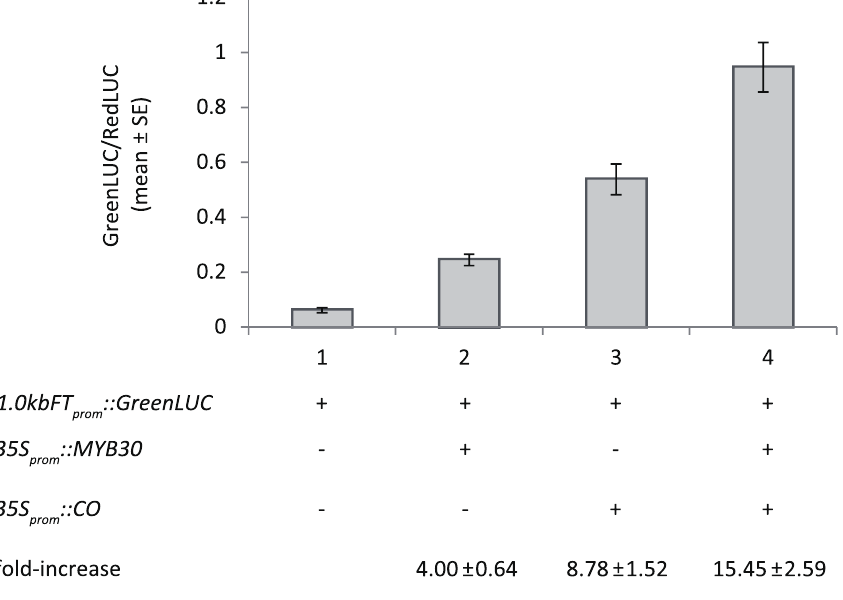
Figure 6. MYB30 increases 1.0 kb FT promoter activity. Leaves from Col plants grown in SDs were bombarded with particles carrying 1.0kbFT prom ::GreenLUC combined with 35S prom ::MYB30,35S prom ::CO or both as indicated. 35S prom ::RedLUC was included to measure transformation efficiencies. Values are shown as relative GreenLUC compared to RedLUC signals (top panel) after a 16 h–24 h incubation in constant light conditions. Fold-induction over the baseline level obtained for 1.0kbFT prom ::GreenLUC alone is indicated in the table below the graph. Values are averages of measurements of five independent leaves from two technical replicates of one bombardment experiment. The experiment was repeated three times with similar results.